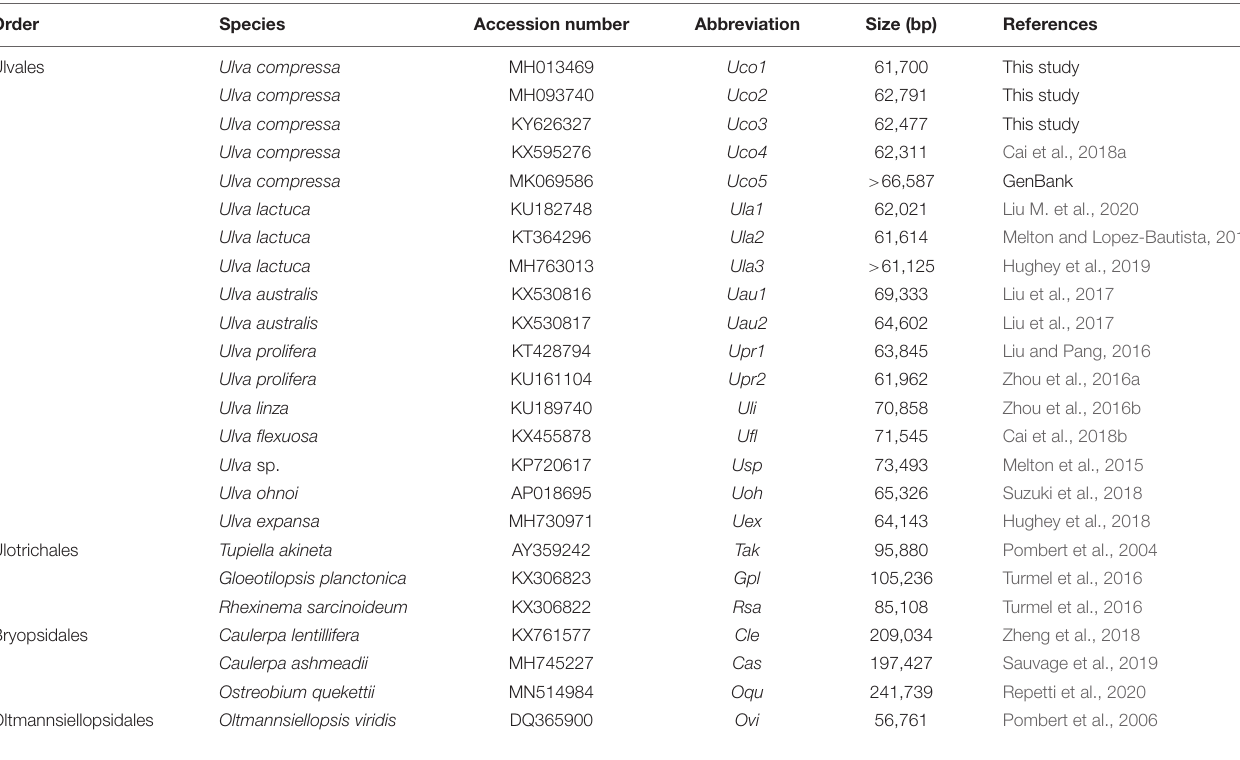
TABLE 1 | The known 24 mitochondrial genomes from 16 ulvophycean taxa in the class Ulvophyceae.